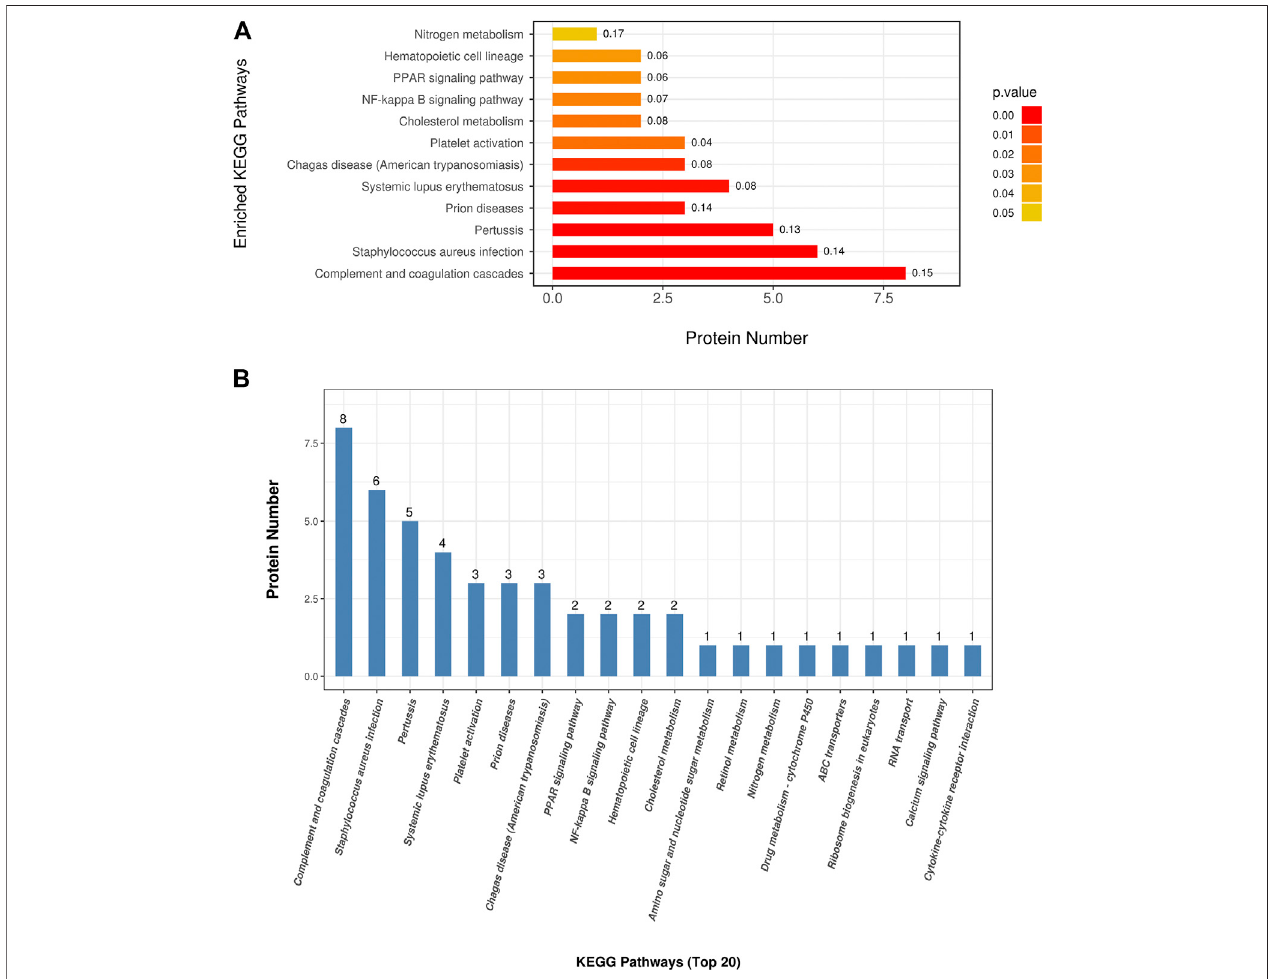
FIGURE 4 | Kyoto Encyclopedia of Genes and Genomes (KEGG) enrichment analysis of differential abundant proteins. (A) Enriched terms in KEGG enrichment analysis with p values less than 0.05. (B) Top 20 KEGG terms with largest enriched protein numbers in KEGG enrichment results.